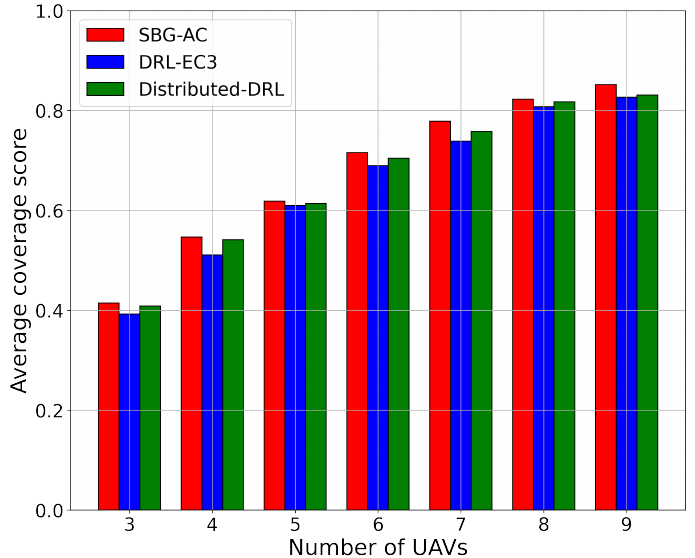
Figure 3. Average coverage score value for a 3-, 4-, 5-, 6-, 7-, 8-, and 9-UAV